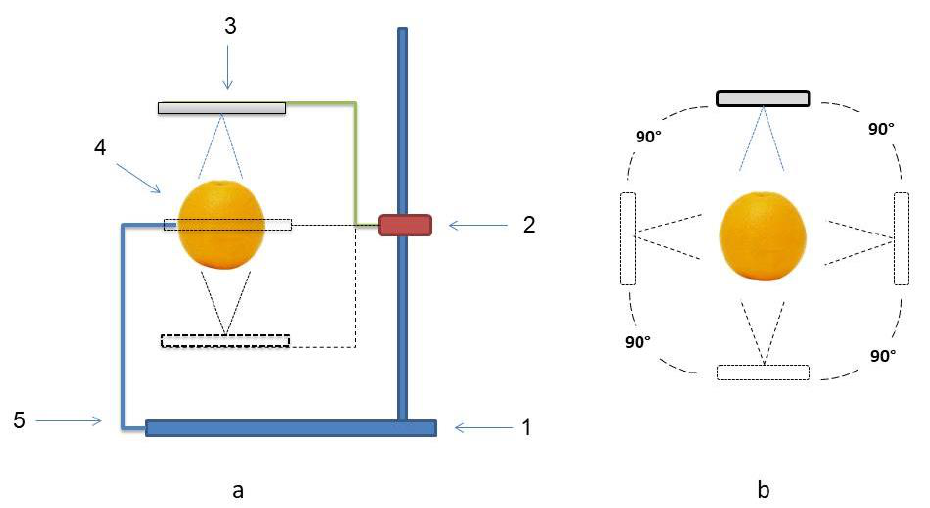
Figure 2. A diagram of pictures taking platform. ( a ) Side view; ( b ) arm rotation angle; (1) the base; (2) servo motor; (3) iPhone mobile; (4) orange fruit; (5) fruit stabilizer.